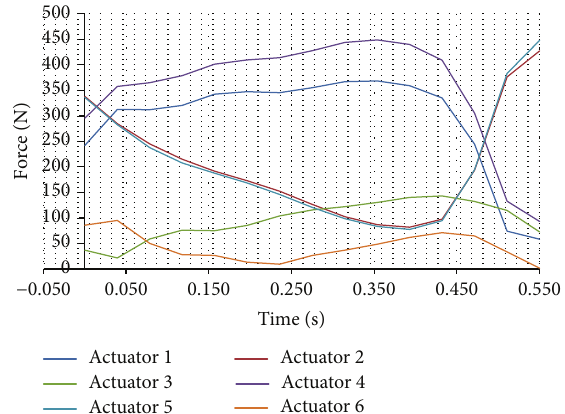
Figure 7: Average required force of six actuators during a single